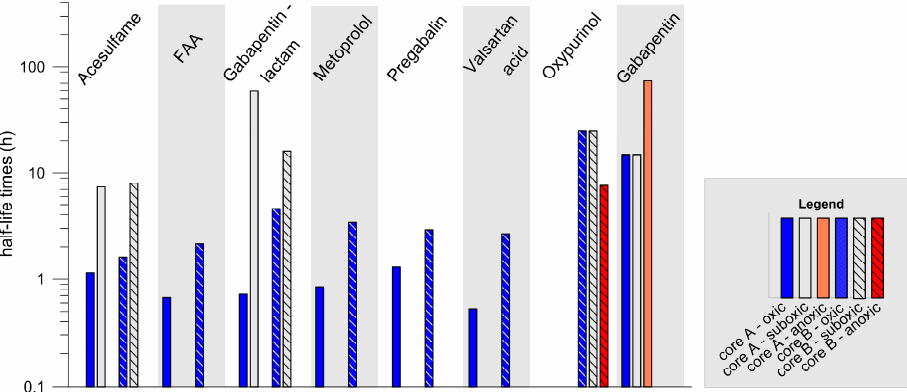
Figure 4. Compilation of observed half-life times (hours) along core A (solid filled bars) and as well as along core B (striped bars) under distinct redox conditions. FAA: